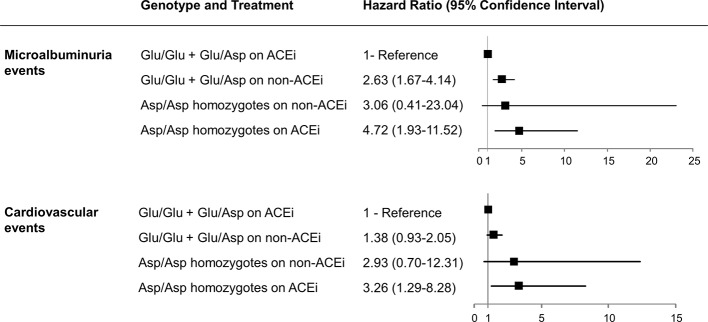
Hazard ratios for considered events according to p.Glu936Asp genotype and ACEi treatment. Adjusted hazard ratios (95% confidence intervals) for microalbuminuria and cardiovascular events according to p.Glu936Asp genotype and ACEi therapy compared with Glu/Glu+Glu/Asp patients on ACEi therapy taken as the reference group are shown.